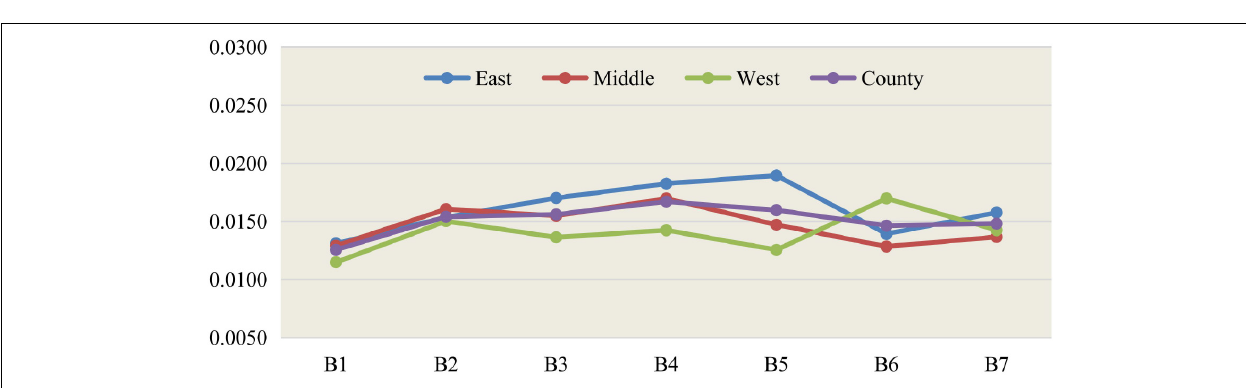
FIGURE 2 | Line chart of social development level scores of three regions from 2016 to